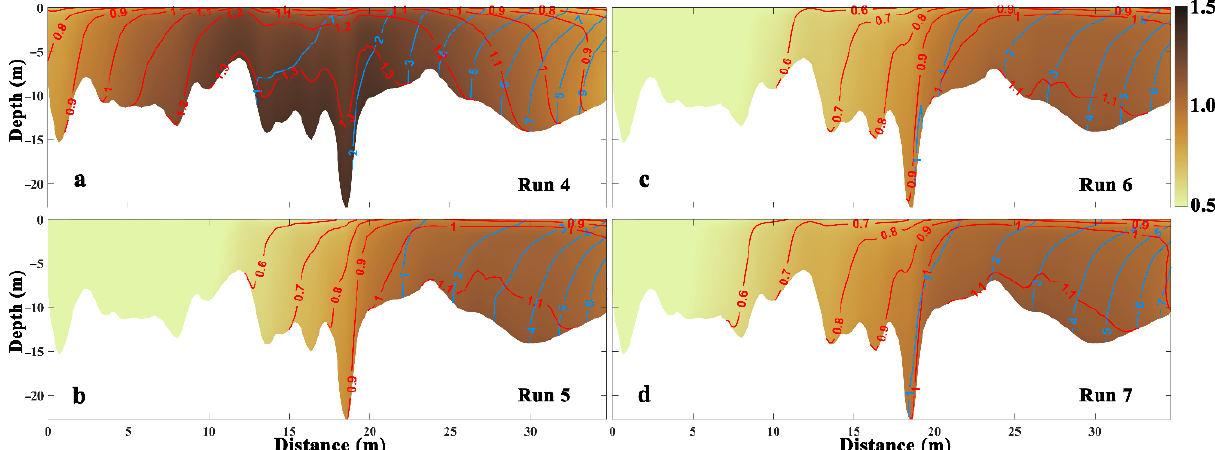
Figure 13. Tidally averaged SSC (red lines and filled contour, unit: kg·m − 3 ) and salinity (blue lines, unit: PSU) distribution on the along-channel section during spring tide when river SSC is set to 0 under ( a ) the low-discharge condition, ( b ) a 2-day-PRD duration, ( c ) a 3-day-PRD duration and ( d ) a 4-day-PRD duration. The SSC is in 0.1 kg·m − 3 intervals and the salinity is in 1-PSU intervals.